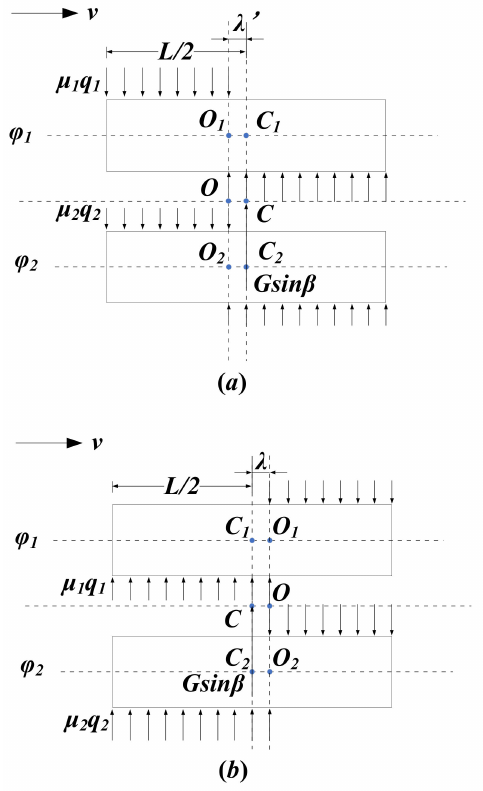
Figure 16. The lateral direction load distribution of the track on the upper and lower sides on the lateral slope: ( a ) the upper side locks first (steering down the slope); ( b ) the lower side locks first (steering up the